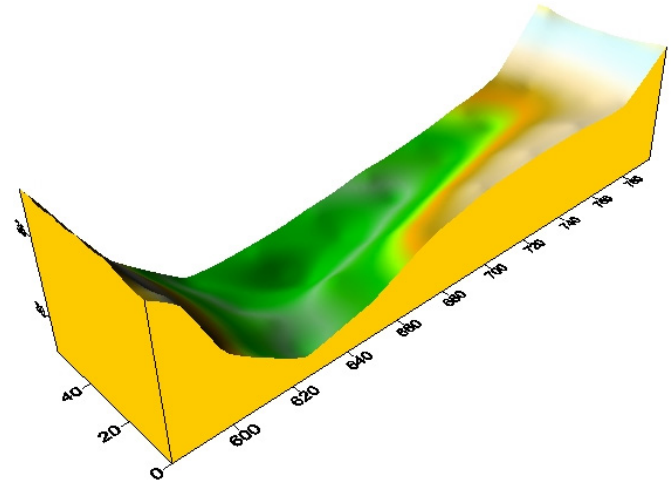
Figure 6. Local scour in sandy washout bed (measurement no. 8 in conditions of Q w = 0.040 m 3 ·s ⁻ ¹ and H = 0.1 m).